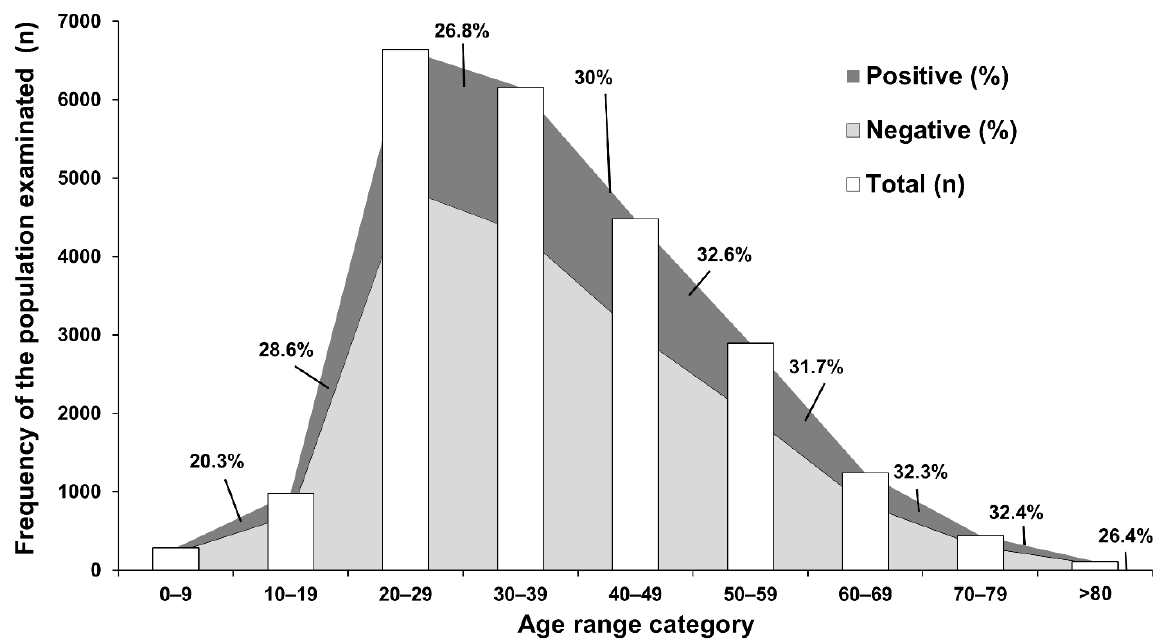
Figure 1. The SARS-CoV-2 epidemiological description along April–December 2020. The largest proportion of patients was represented by group among 20–29 years old, but those in the 40–49, 70–79, and 40–69 groups showed the greatest proportion of positive patients to SARS-CoV-2.